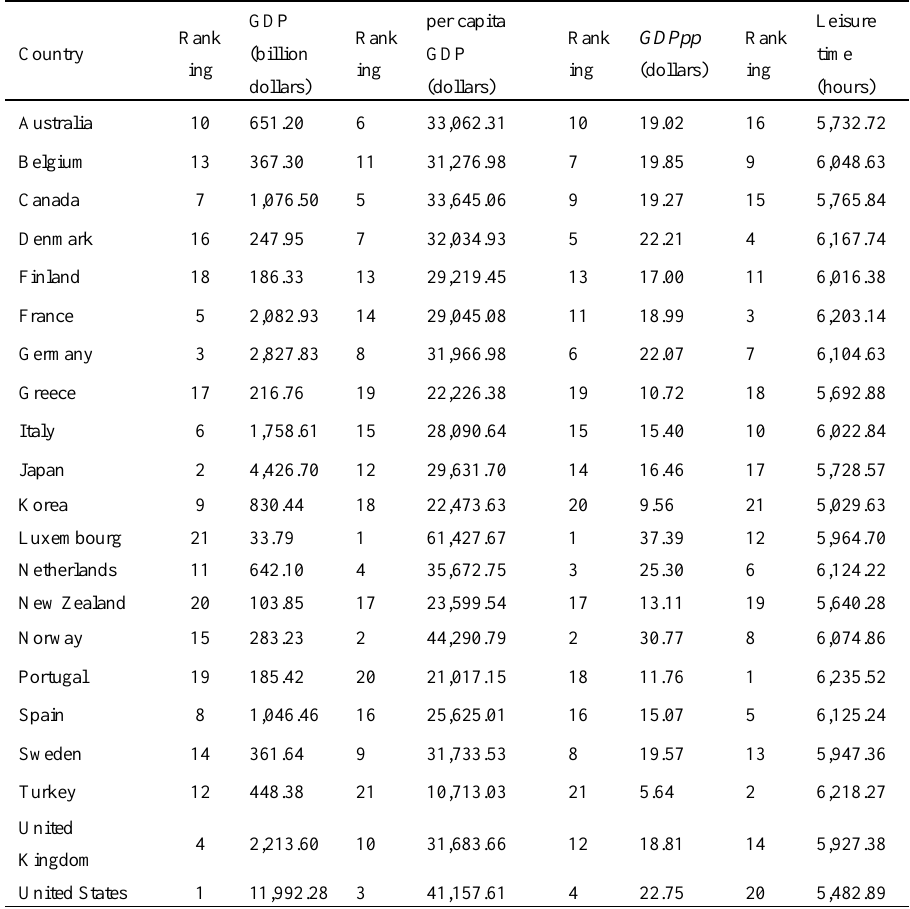
Table 4: Rankings of average GDP, per capita GDP, per capita per hour GDP ( GDPpp ), and leisure time of OECD countries in the 1980–2013